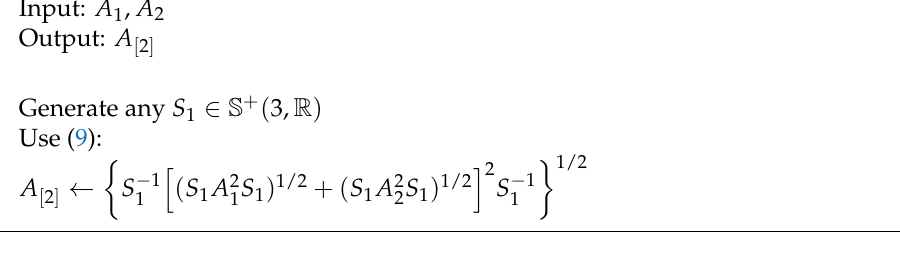
Algorithm A4 Function: Compute a Kurzhanski’s inner bound